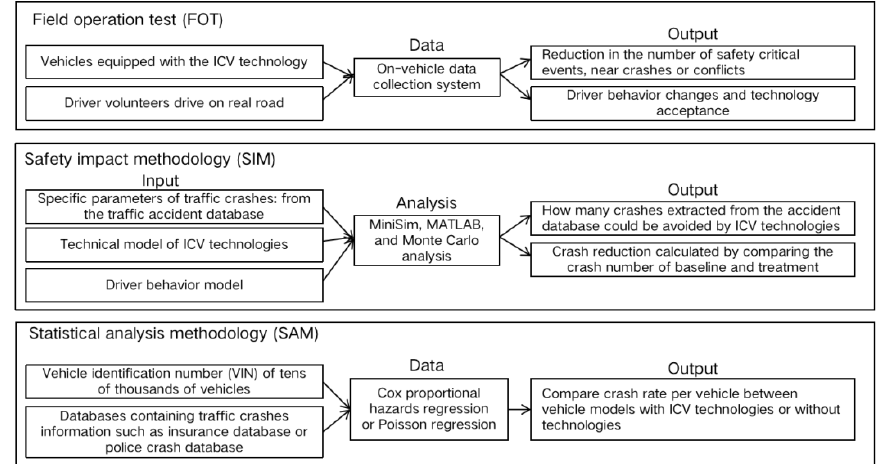
Figure 1. Three methods for evaluating the effectiveness of ICV